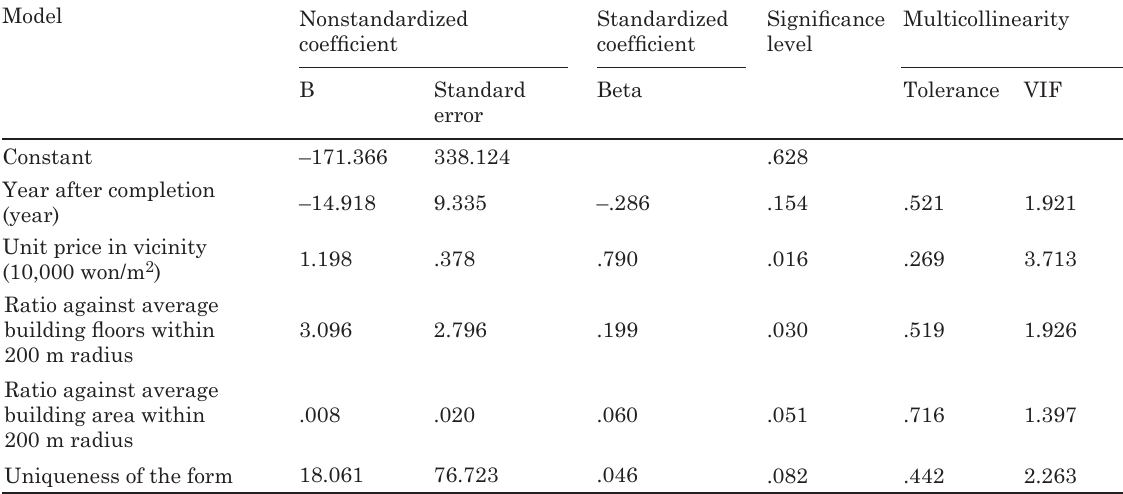
table 11. results of regression analysis of Gangnam-area and yeongdeungpo-gu